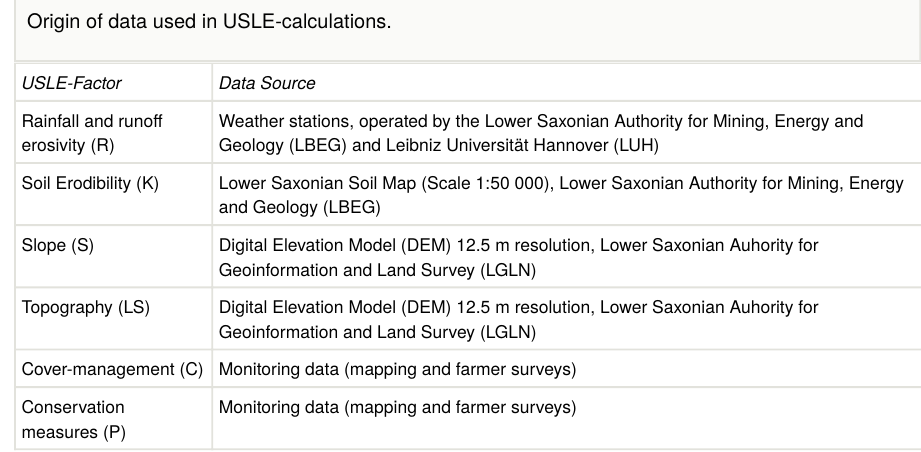
Cover-management (C) Monitoring data (mapping and farmer surveys) Conservation Monitoring data (mapping and farmer surveys) measures (P) Rainfall and runoff erosivity (R-factor)